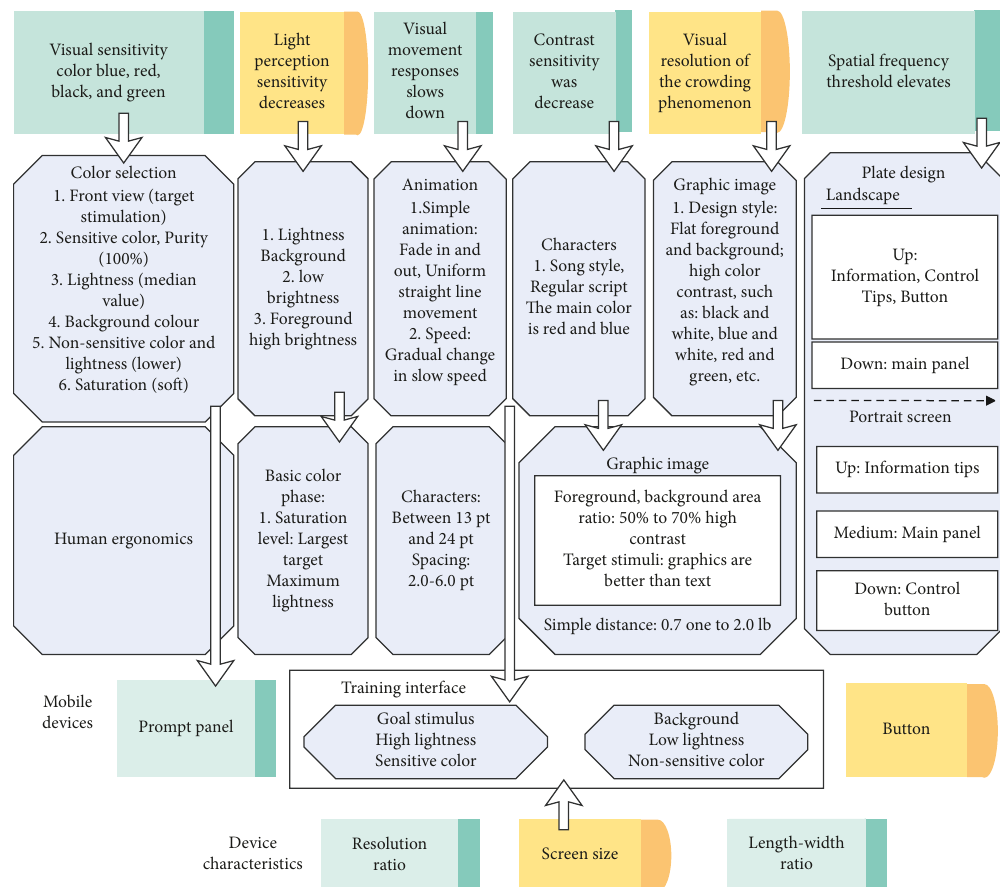
Figure 8: UI design scheme of mobile vision training